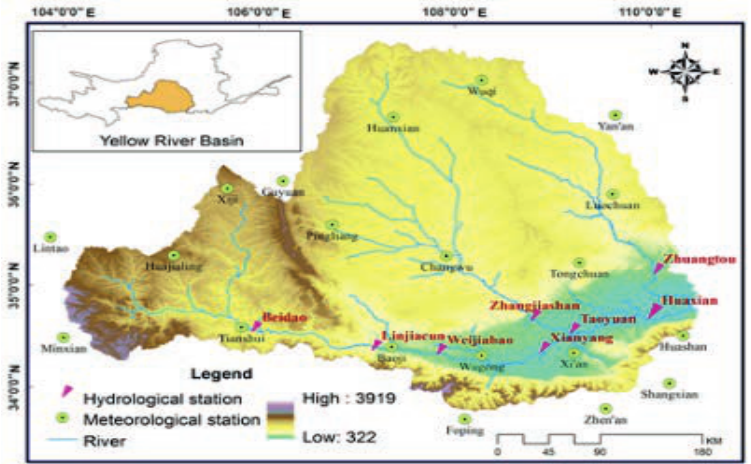
Fig. 1. Map of the Weihe River Basin and its location within the Yellow River basin (insert).